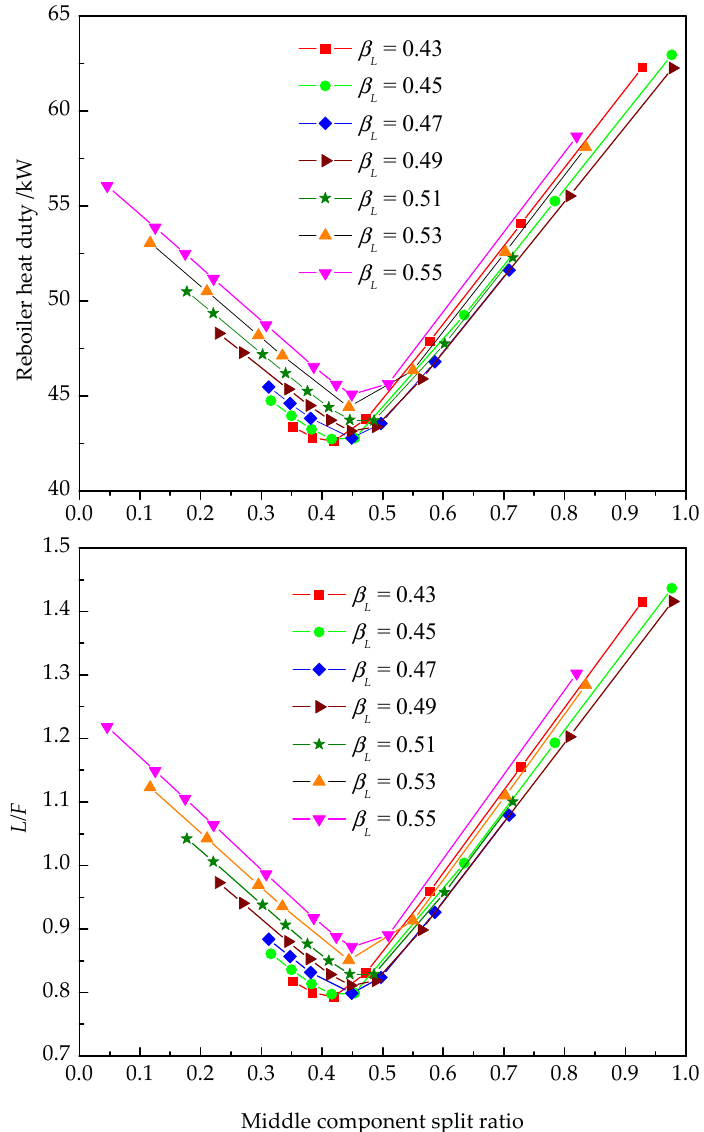
Figure 11. The middle component split ratio at the top of column versus L / F and the heat duty of reboiler.